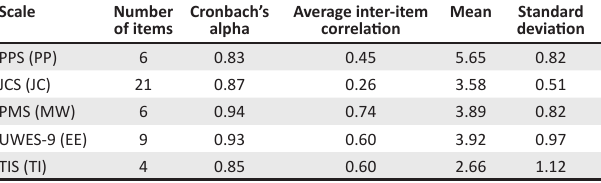
FIGURE 1: Proposed employee engagement and turnover intention structural TABLE 2: Psychometric properties of measuring instruments.